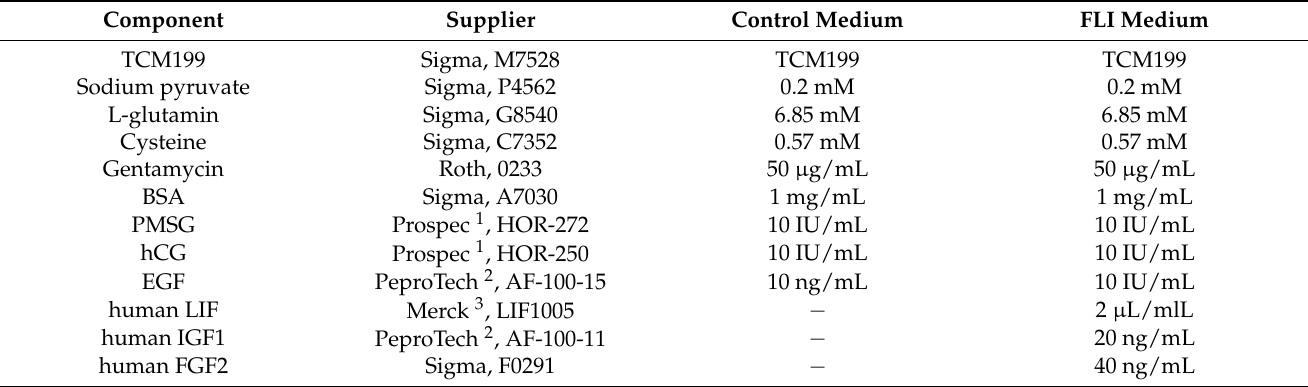
Table 5. The composition of the control and FLI